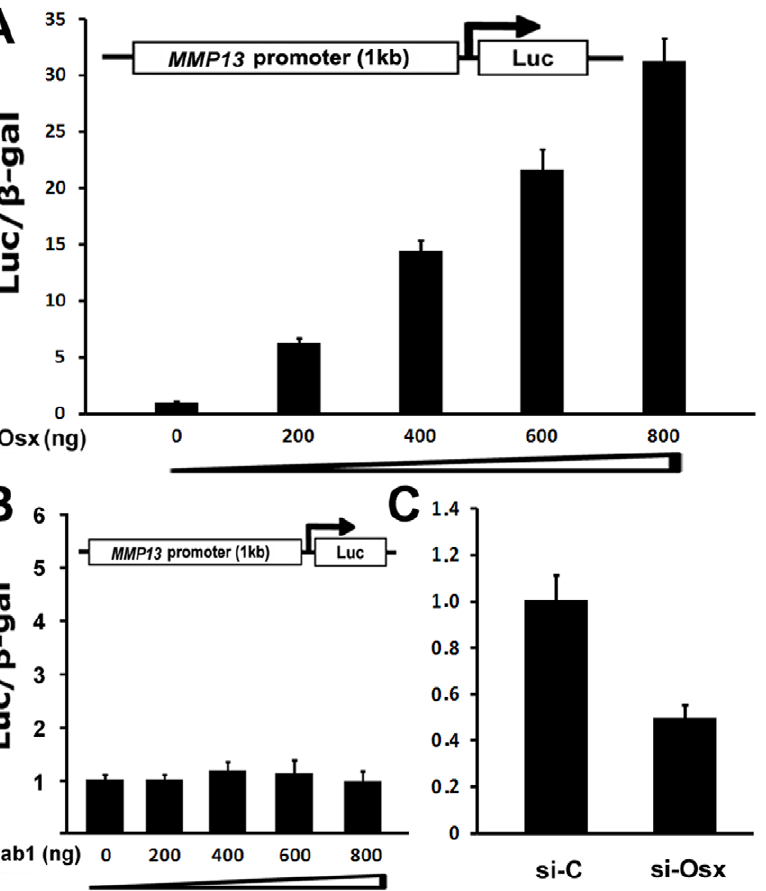
Figure 4. Effect of Osx on MMP13 promoter activity. ( A ) Osx activates the MMP13 promoter in a dose-dependent manner. HEK293 cells were transfected with a 1 kb MMP13 promoter-luciferase reporter gene without or with increasing amounts of an Osx-expression plasmid as indicated. Luciferase activity was normalized by b -galactosidase activity. Values are presented as the mean 6 S.D. (B) Jab1 does not activate MMP13 promoter activity. HEK293 cells were transfected with a 1 kb MMP13 promoter-luciferase reporter gene without or with increasing amounts of a Jab1- expression plasmid as indicated. Luciferase activity was normalized by b -galactosidase activity. Values are presented as the mean 6 S.D. (C) MMP13 promoter activity is inhibited in the presence of Osx siRNA. MC3T3 osteoblastic cells were transfected with a 1 kb MMP13 promoter-luciferase reporter gene with siRNA Control or Osx siRNA as indicated. Luciferase activity was normalized by b -galactosidase activity. Values are presented as the mean 6